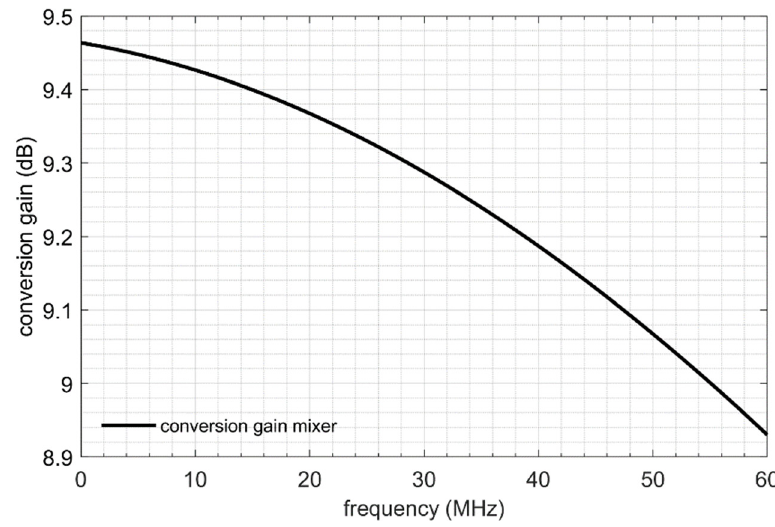
Figure 15. Voltage conversion gain of the mixer.